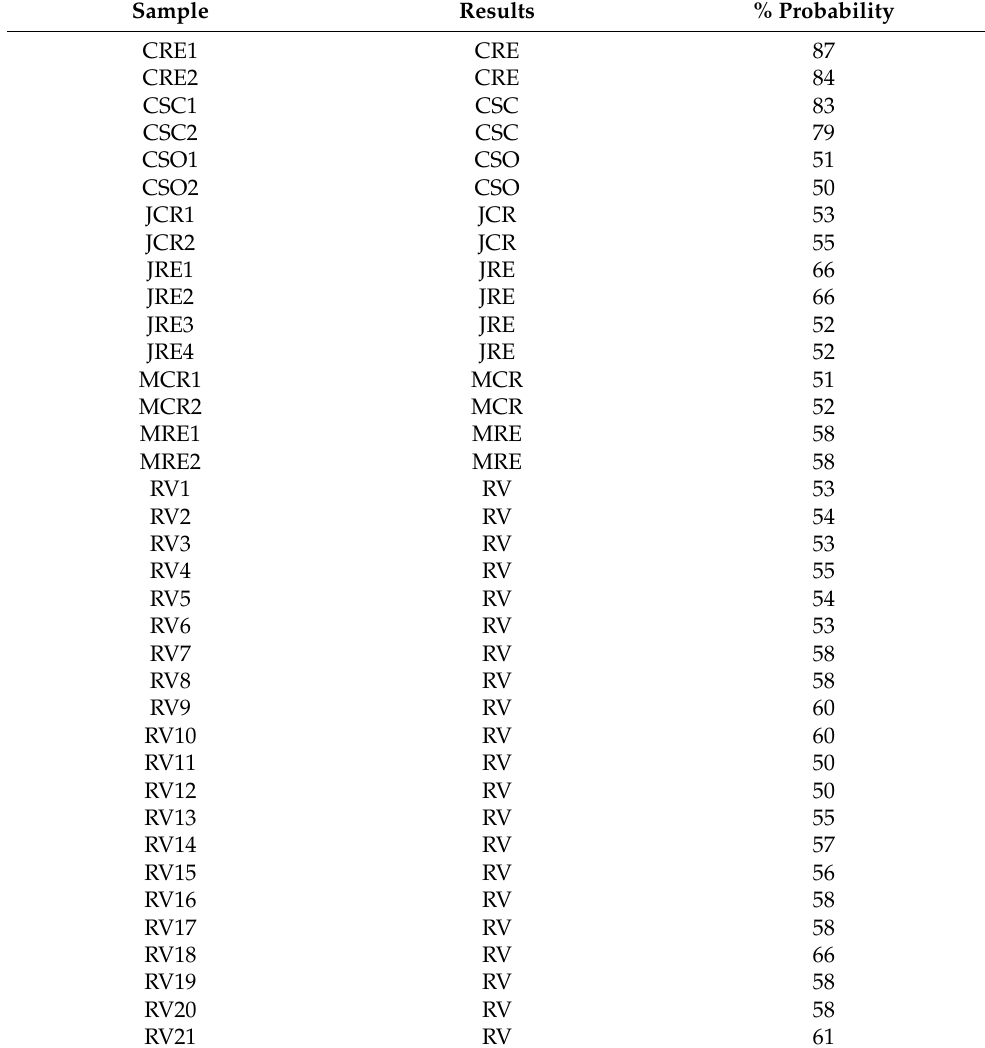
Table 2. Classification results (i.e., identification of the type) and % of probability provided by VinegarScan tool for the test samples included as an example in the